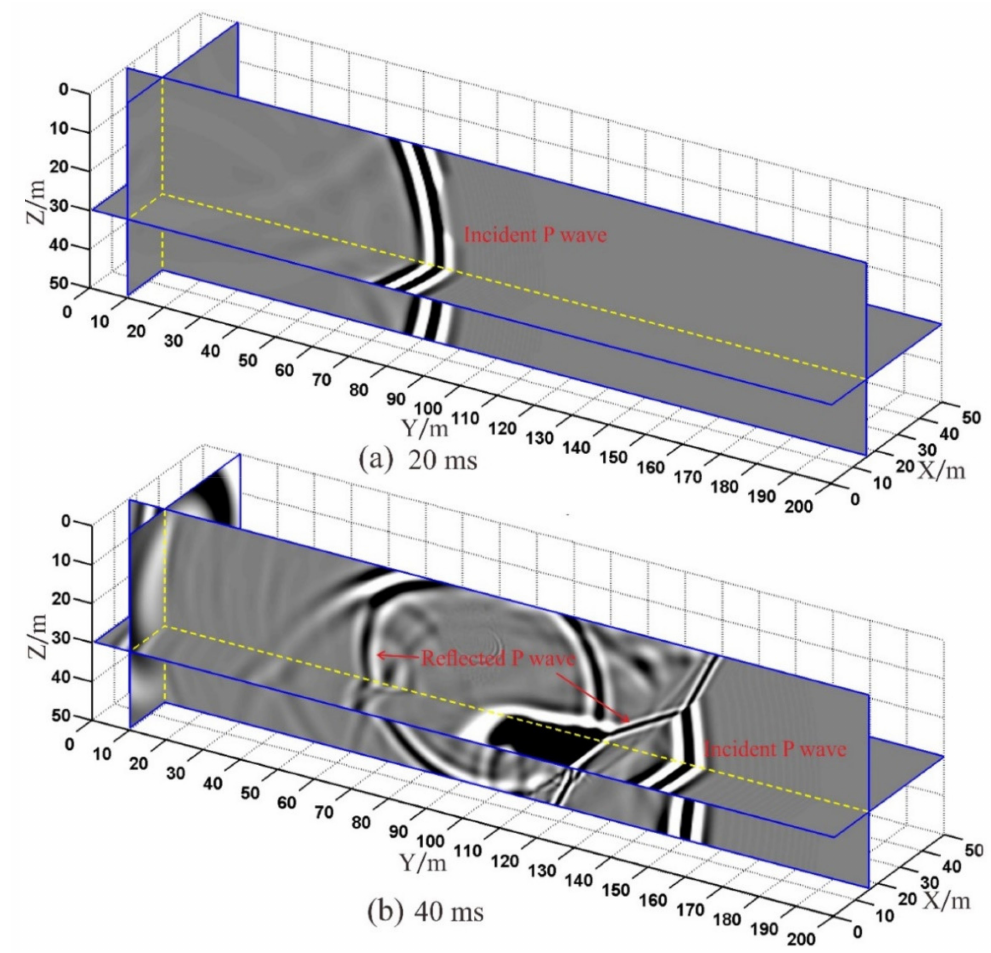
Figure 4. The snapshots of the wavefield: ( a ) 20 ms moment; ( b ) 40 ms moment. Figure 5 shows the three-component wave field recording received by geophone R-1. Symbol A denotes the direct wave that has linear characteristics. The symbol A1 denotes the reflection wave from the tunnel-top interface and shows hyperbolic characteristics. The energy of the Z-component reflection event (A1) is the strongest. The symbol A denotes the direct wave, A1 the reflection wave from the tunnel top interface, B to D the reflection wave from the karst cave, E and F the reflection wave from the interlayer. G is the multiple waves and generated from the interlayer. The reflected waves of the X and Y component are very similar, but they have a slight difference from the Z-component. D and G are the most